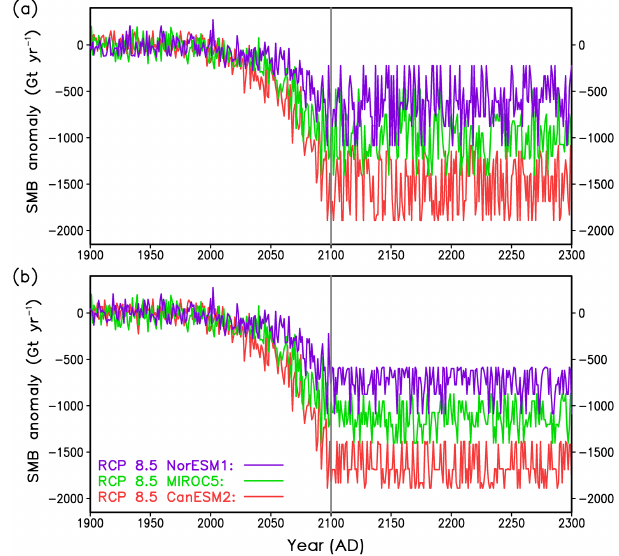
Figure A1. Prolongation of the MAR forcing illustrated for the SMB anomaly. (a) For the years 2101–2300, the SMB anomalies are taken from random years between 2091–2100. (b) Variability for the years 2101–2300 reduced by 30%. The vertical grey line at the year 2100 indicates the beginning of the